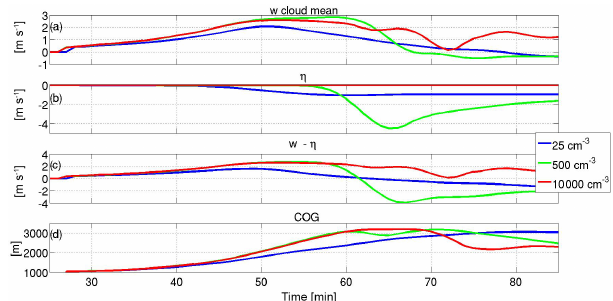
Figure 1. (a) Mean vertical velocity ( w ), (b) mean effective ter- minal velocity ( η ), (c) mean vertical velocity plus effective terminal velocity, and (d) cloud center of gravity (COG) as a function of time for three different aerosol